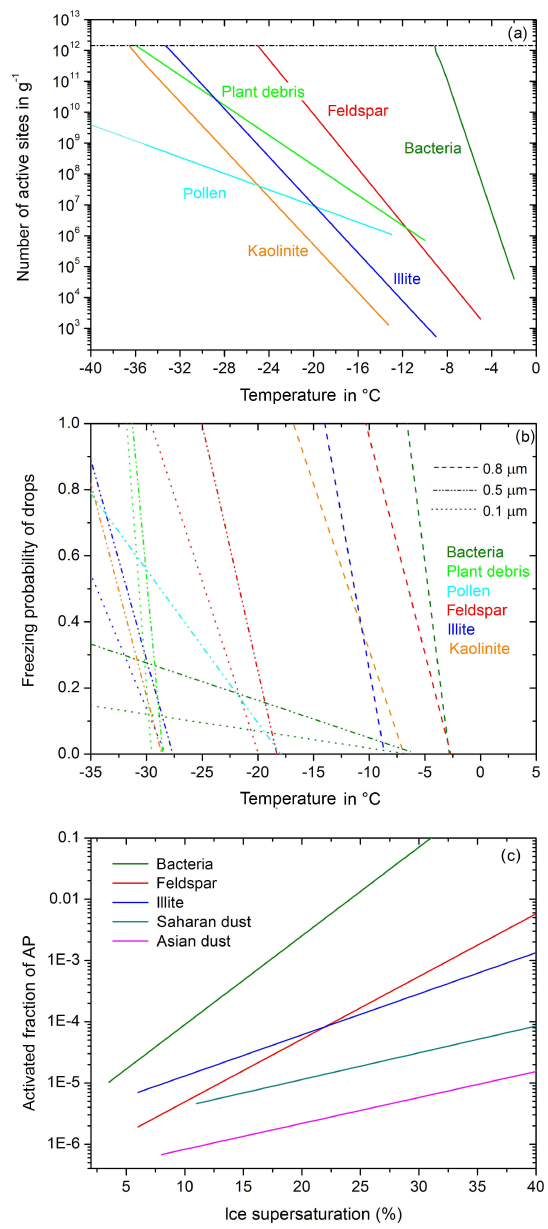
Figure 1. Parameterizations of heterogeneous freezing. (a) Immer- sion freezing: numbers of active sites per unit mass as a function of temperature; from Diehl and Mitra (2015), with new data for plant debris based on Hiranuma et al. (2015). (b) Contact freezing: freezing probability of drops in the contact mode as a function of temperature; from Diehl and Mitra (2015), with new data for pollen and plant debris according to Hoffmann (2015) and Hiranuma et al. (2015). (c) Deposition nucleation: activated fraction of particles as a function of ice supersaturation; from Diehl and Mitra